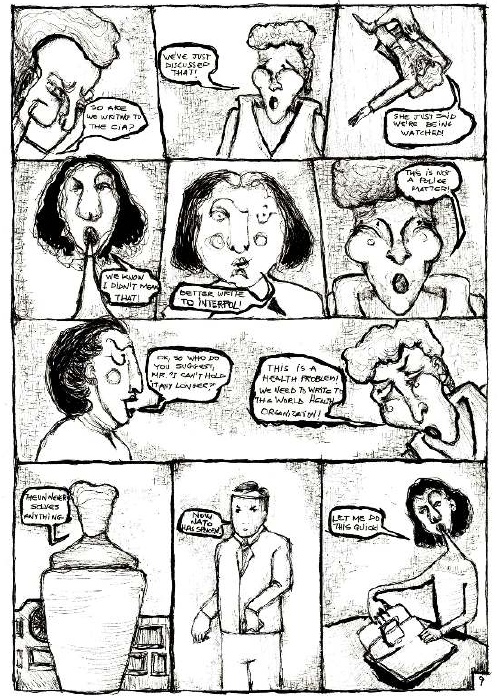
Credits: Amine Barbuda.